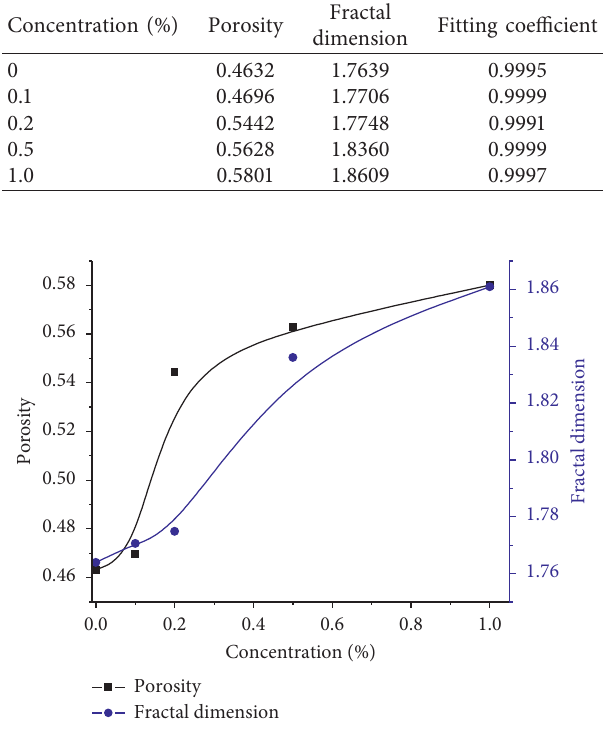
Figure 8: Relationship curve of zinc ion concentration with po- rosity and fractal